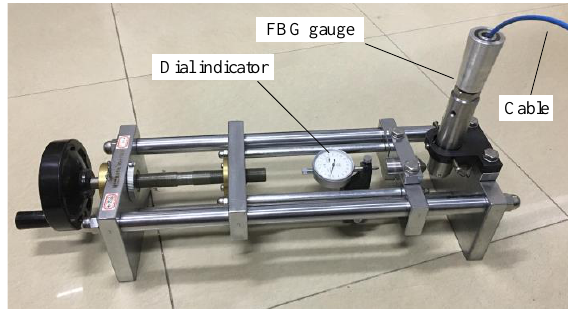
Figure 6. Calibration setup.